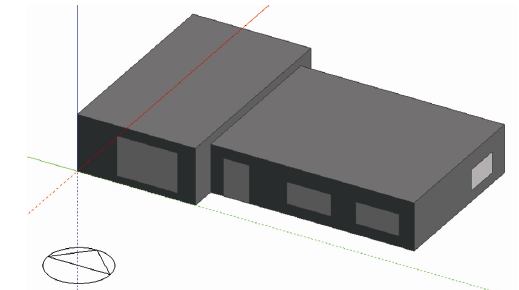
Fig. 3. The geometrical model of the house